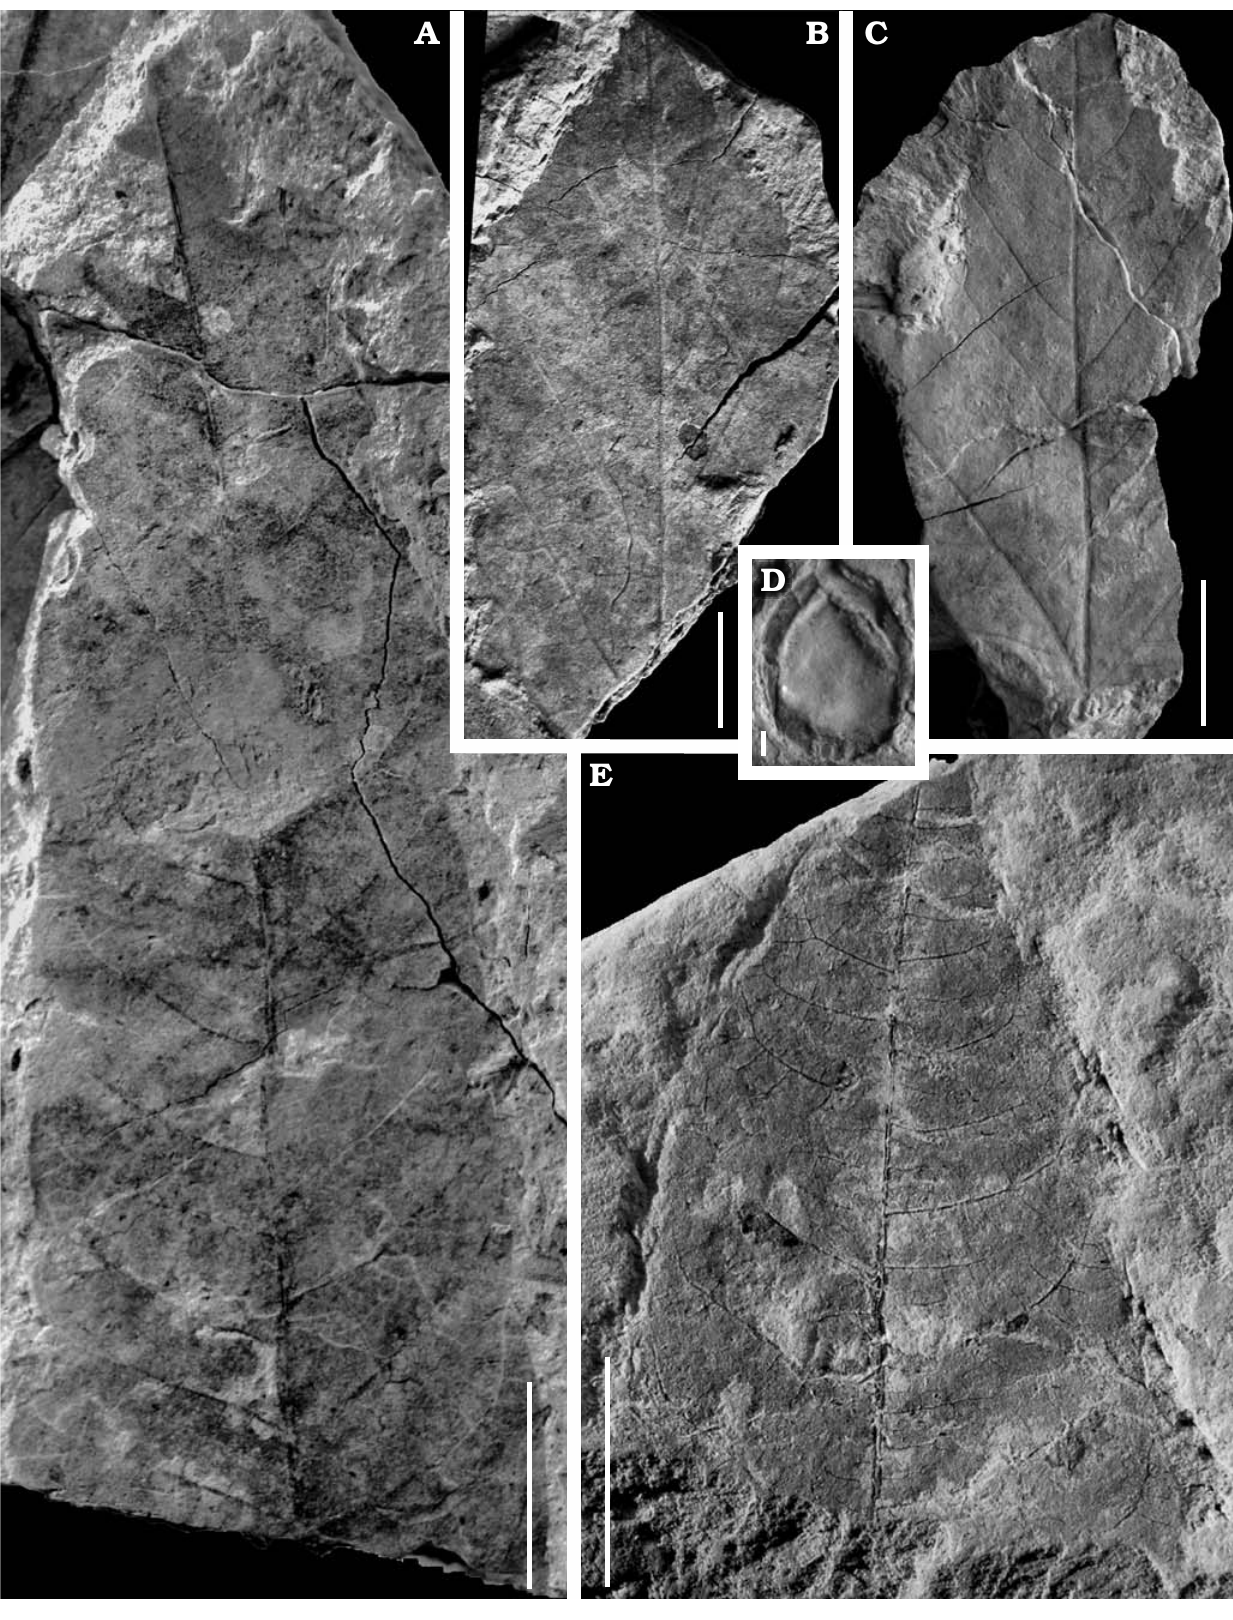
Fig. 7. Angiosperms impressions from Ł ysa Góra near R ę biszów, Poland, late Oligocene. A , E . cf. Cedrela macrophylla Andreánszky, 1955, leaves. A . KRAM-P 128/570. E . KRAM-P 128/516. B . Alnus cf. gaudinii (Heer, 1856) Knobloch and Kva č ek, 1976, KRAM-P 128/390, leaf. C . cf. Acer tricus- pidatum Bronn, 1838, KRAM-P 128/388, leaf. D . Prunus cf. scharfii Gregor, 1978, KRAM-P 128/352, endocarp. Scale bars: A–C, E, 10 mm; D, 1